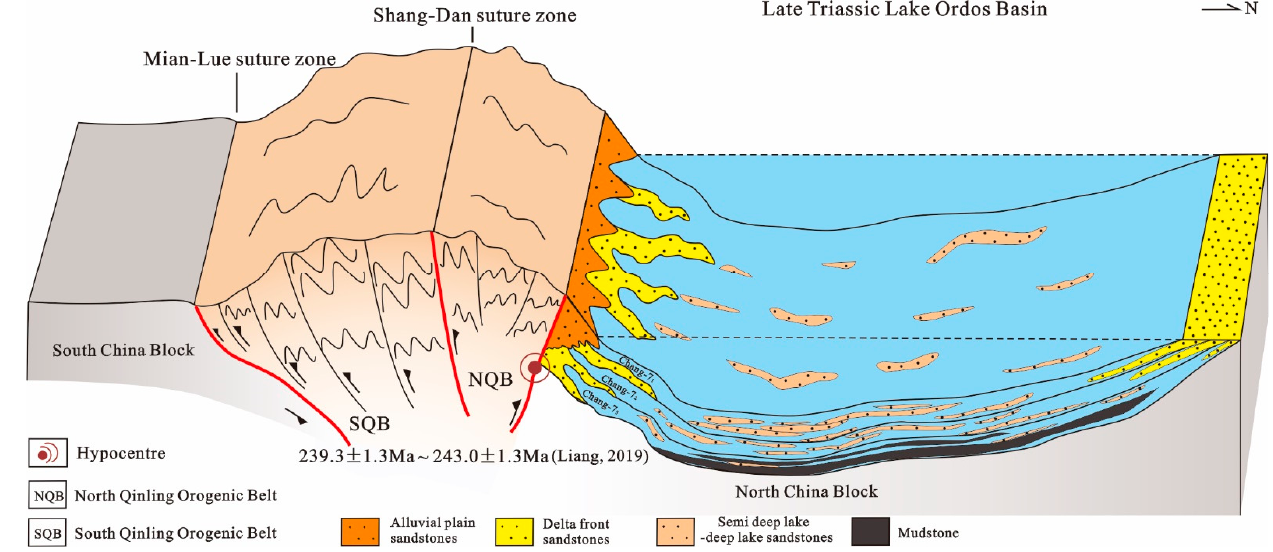
Figure 4. Model of the collisional setting during accumulation of the Chang-7 Member [36].